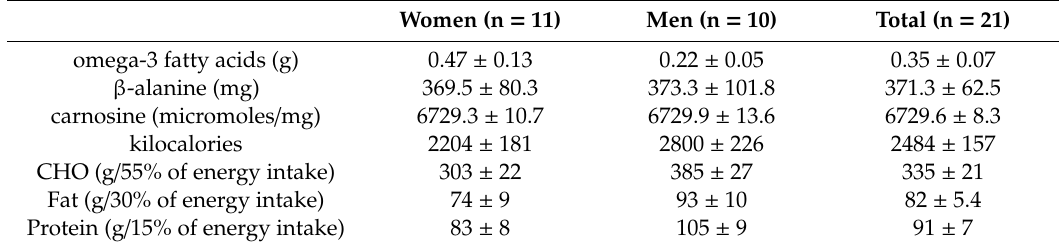
Table 2. Participant’s omega-3, β -alanine and carnosine daily intakes (mean ± sem).